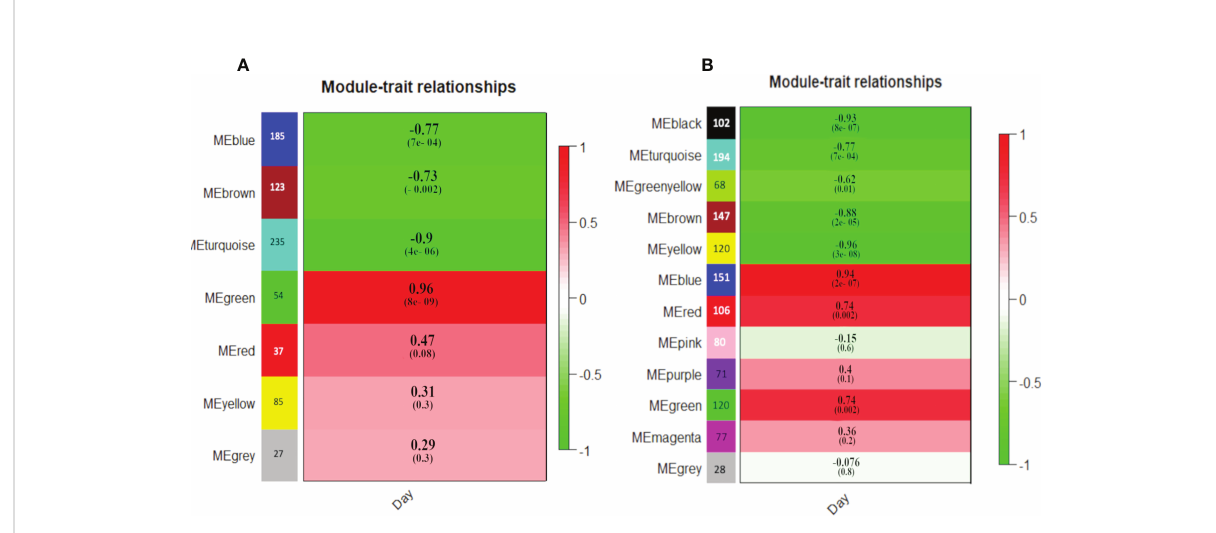
FIGURE 6 Module-Day trait association identi fi ed by WGCNA in SAG peach (A) and BT nectarine (B) . Each row corresponds to a module. The number of genes in each module is indicated on the left. The heat map indicates the correlation of each module with days of storage with the score and signi fi cance (P values in brackets) according to a Pearson